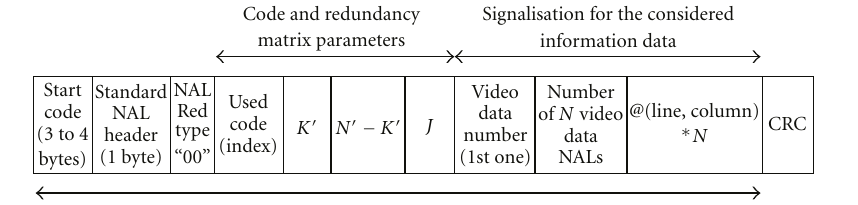
Figure 4: N / M NAL unit 30 proposed format, type “00”.